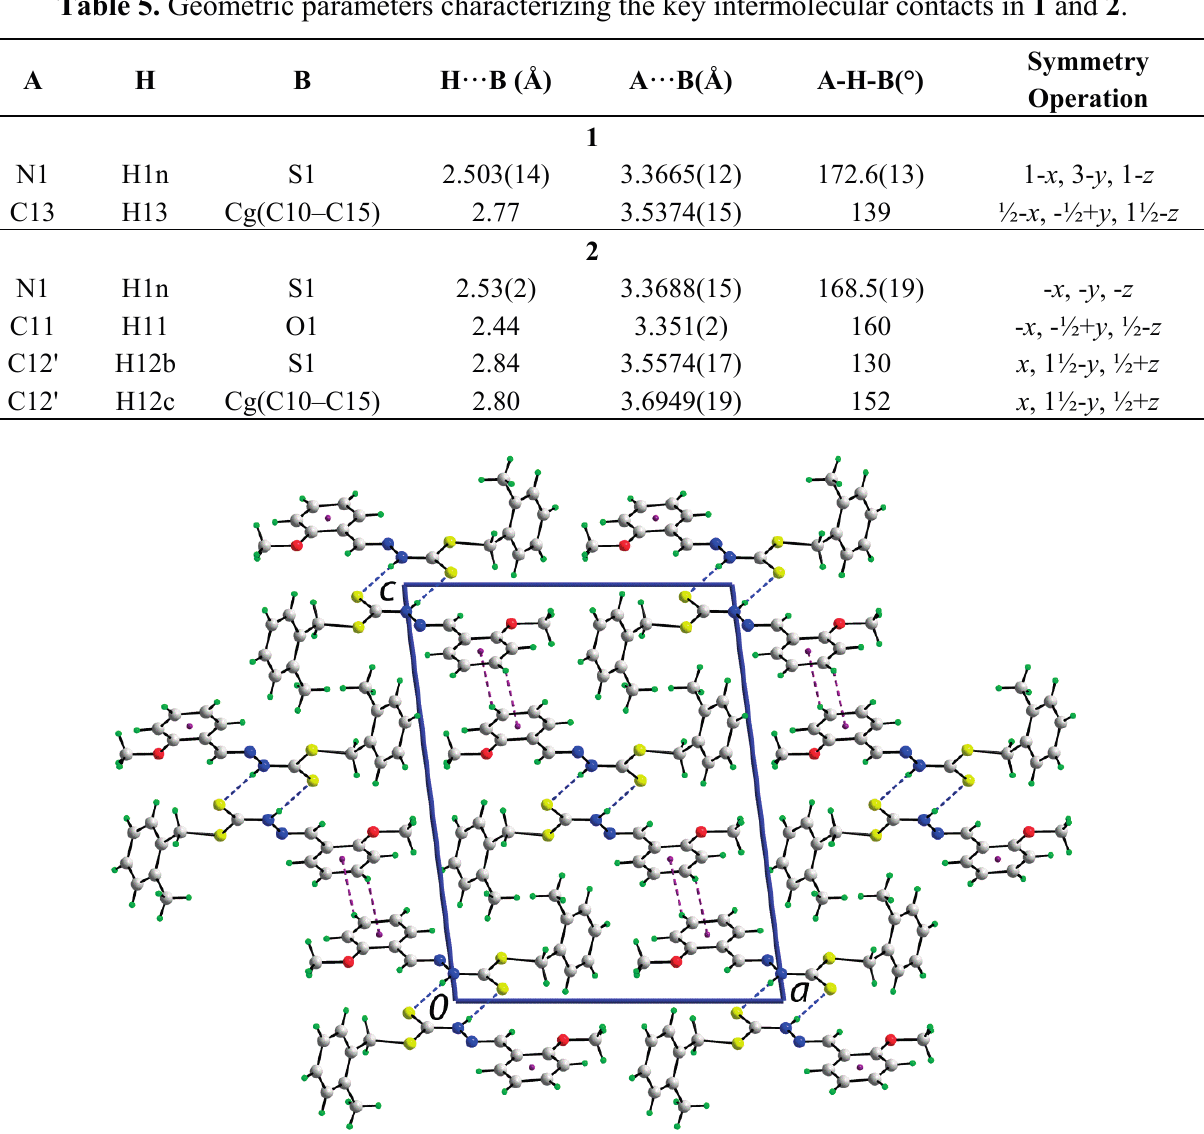
Table 5. Geometric parameters characterizing the key intermolecular contacts in 1 and 2 .